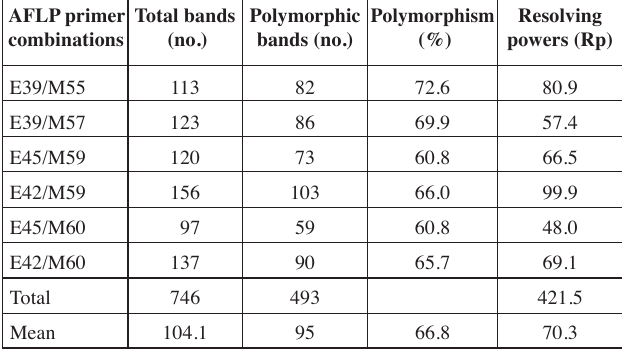
Tab 2: Number of total and polymorphic AFLP bands, percentage of poly- morphic bands, and resolving powers in the DNA-fingerprinting of 40 quince genotypes originating from